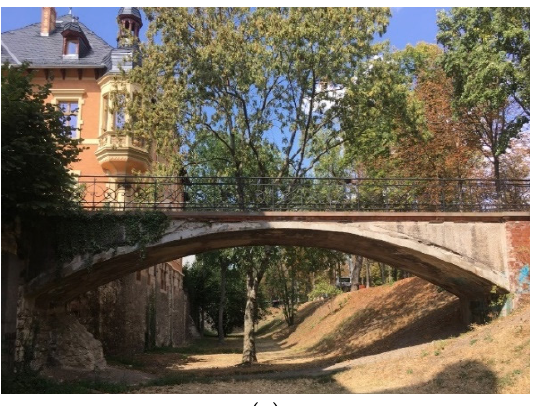
Figure 8. View of the historical arch bridge Thainburg: ( a ) before strengthening; ( b ) after the strengthening with carbon reinforced concrete. (Photos: CARBOCON GMBH).